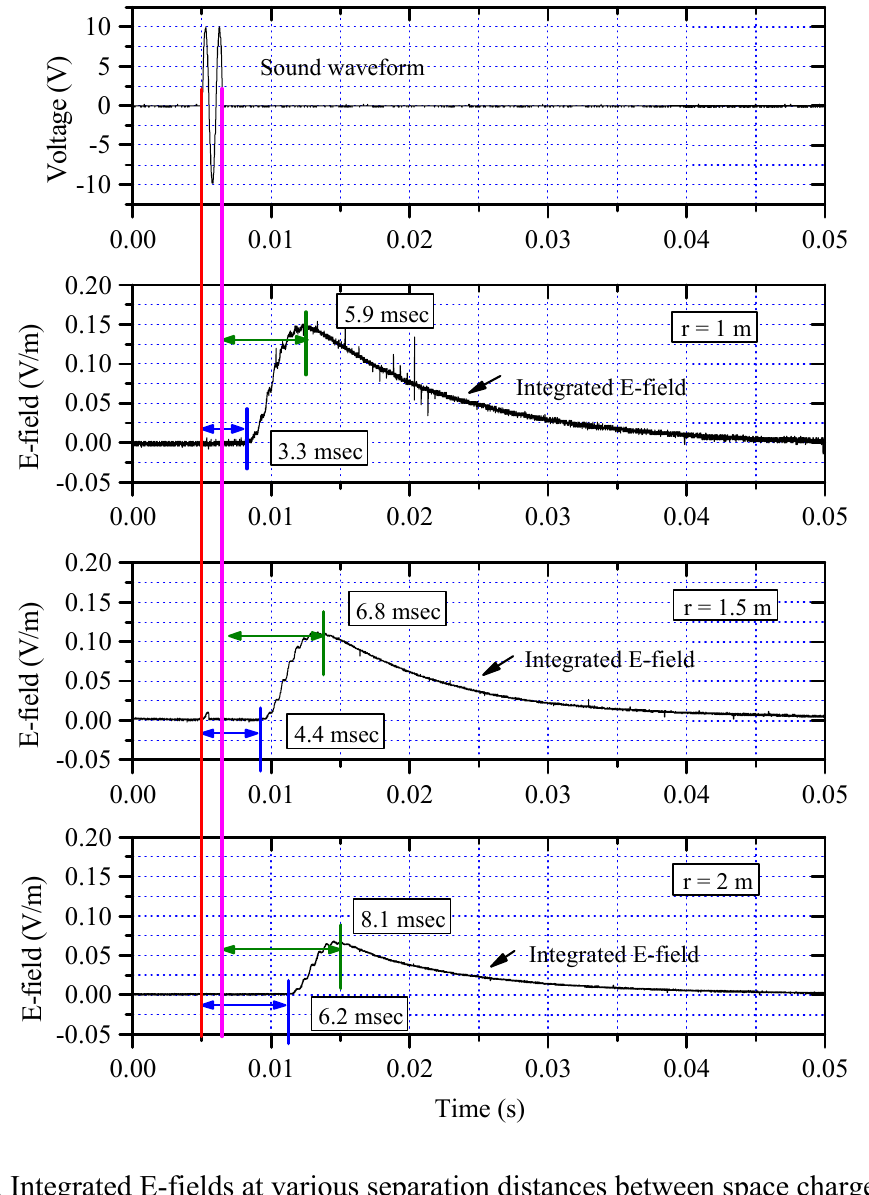
Figure 4 . Integrated E-fields at various separation distances between space charge and the